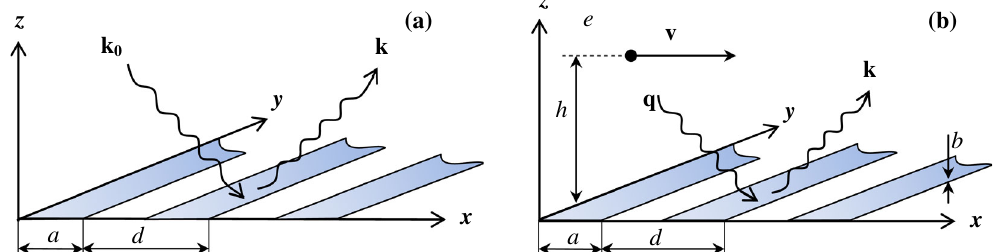
FIG. 1. (a) Reflection of light from a grating. (b) Radiation of a charged particle as a reflection of its own (Coulomb) field from the grating. Velocity of the charged particle is v ¼ ð v x ; v y ; 0 Þ , e is its charge, the size of a single strip is ð a; ∞ ; b Þ , the grating period is d , h is the impact parameter, i.e., the shortest distance between the grating surface and the particle trajectory; k 0 is the wave vector of a photon of incident light, k is the wave vector of a photon of reflected light, q is the momentum of virtual photons of the particle Coulomb